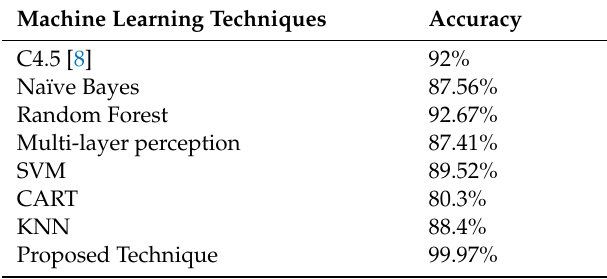
Table 14. The performance of different machine learning techniques.